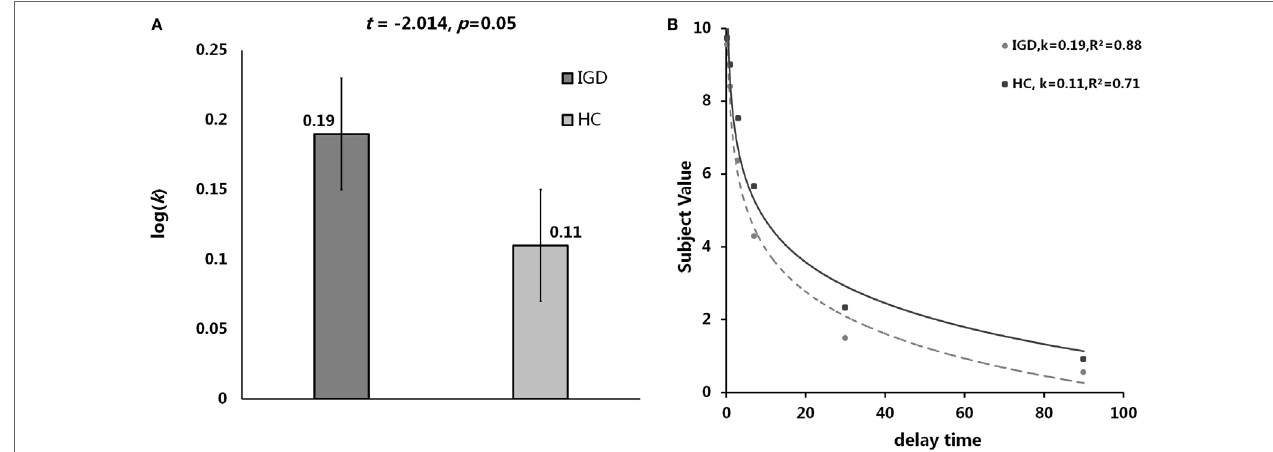
FigUre 2 | Delay discounting value differences between Internet gaming disorder (IGD) and healthy control (HC). (a) The IGD showed higher k value than HC. (b) Delay discount functions for HC and IGD. Points show mean indifferent points for monetary rewards as a function of delay time. R 2 represents how close the fitted curve is from the actual data points. First, the variation between data points and the mean values is calculated. In least-squares fitting, the total sum of squares (TSS) includes two parts: the variation explained by regression and that not explained by regression [the residual sum of square (RSS)]. Then the R 2 = 1 −